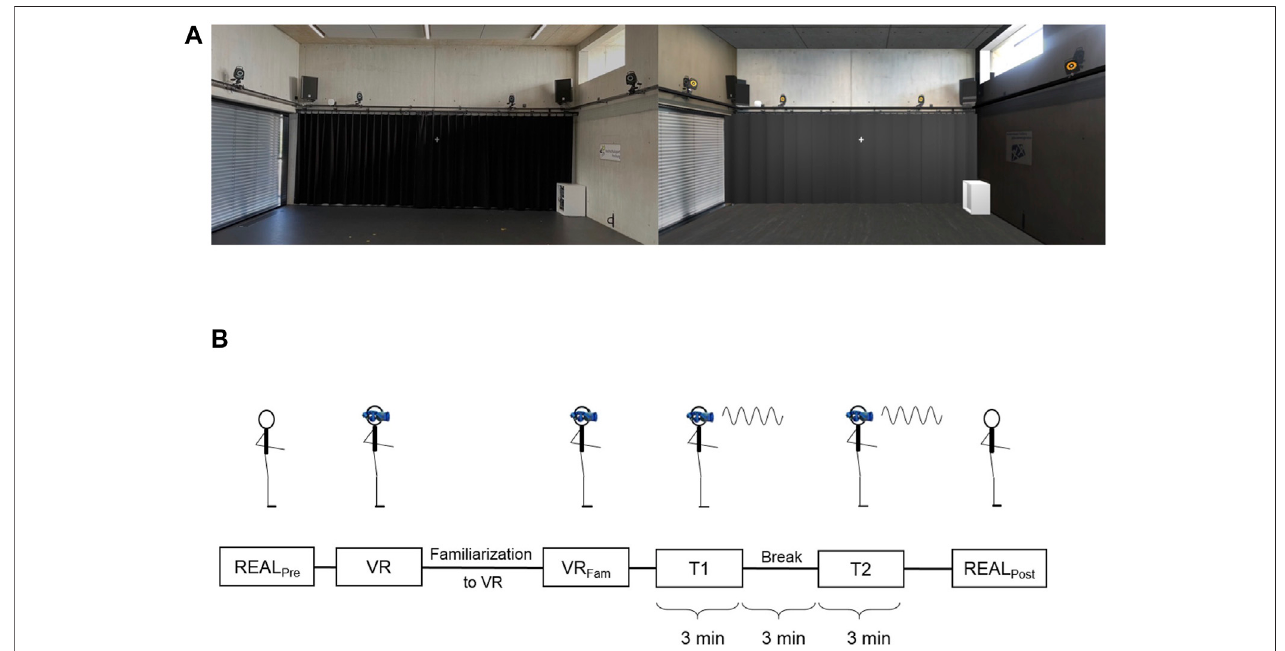
FIGURE1| Experimentalsetup (A) Realenvironment(left)andvirtualreplicaoftherealenvironment(right)thatwasprovidedtothesubjectsviaHMD (B) Schematic display of the experimental protocol.